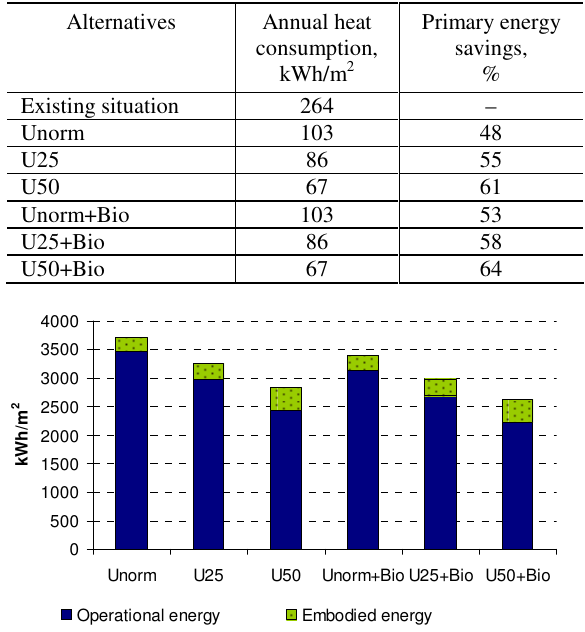
Fig. 1. Life-cycle energy consumption of each